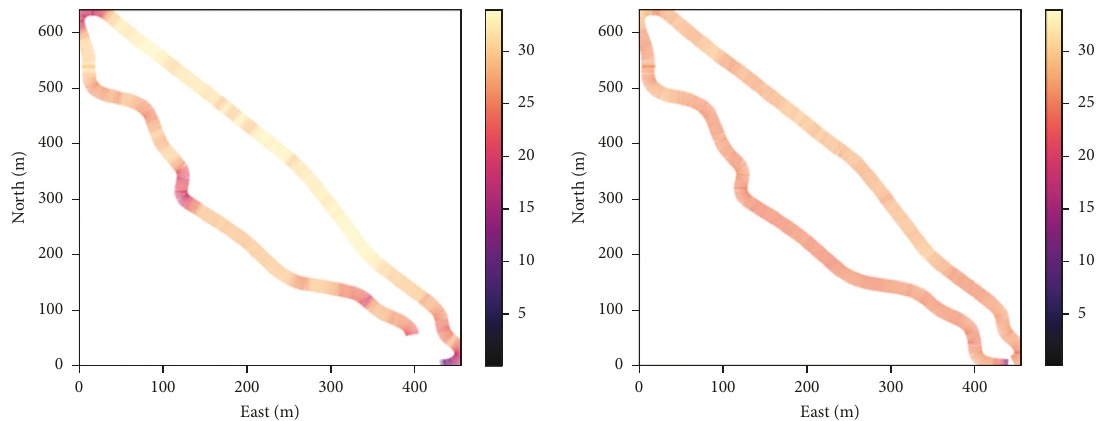
Figure 13: Visualized velocities at each point on the